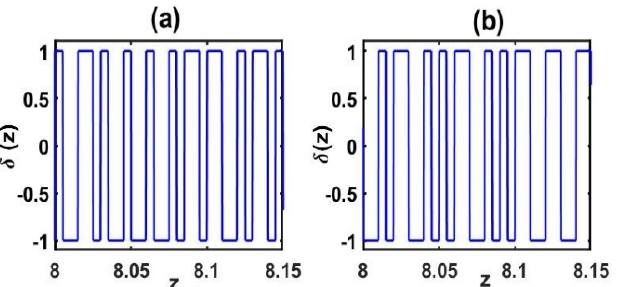
Figure 6. Examples of domain arrangements in the central portion of a QPM quadratic crystal. ( a , b ) The dimensionless cases studied in Figures 2 and 3, respectively.